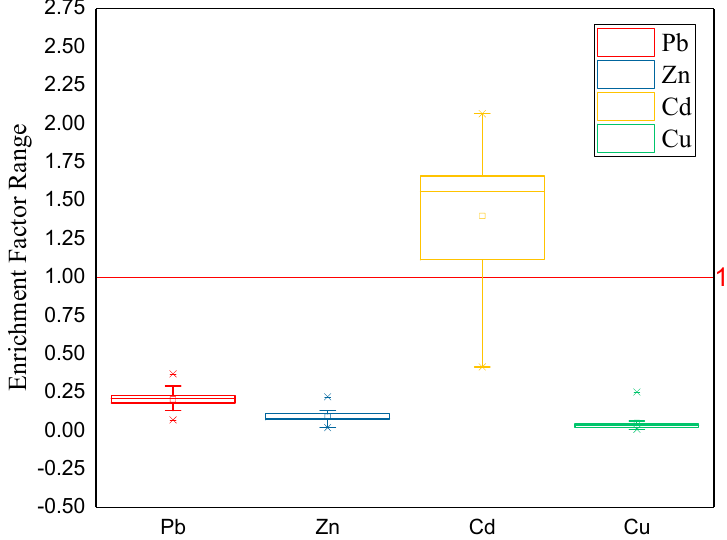
Figure 4. Enrichment factor of surface sediment in the Perak River (straight line at point 1 represents EF index reference line [39,40]; EF < 1, no enrichment; EF 1.0–3.0, minor enrichment; EF 3.0–5.0, moderate enrichment).